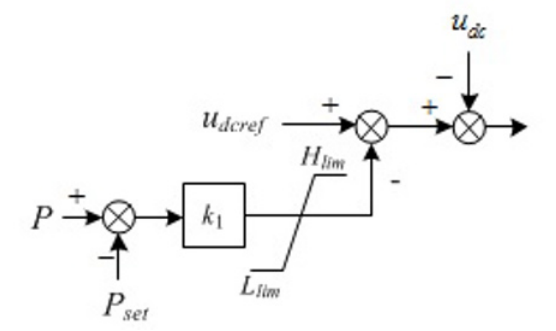
Figure 4. An additional control for dc voltage control